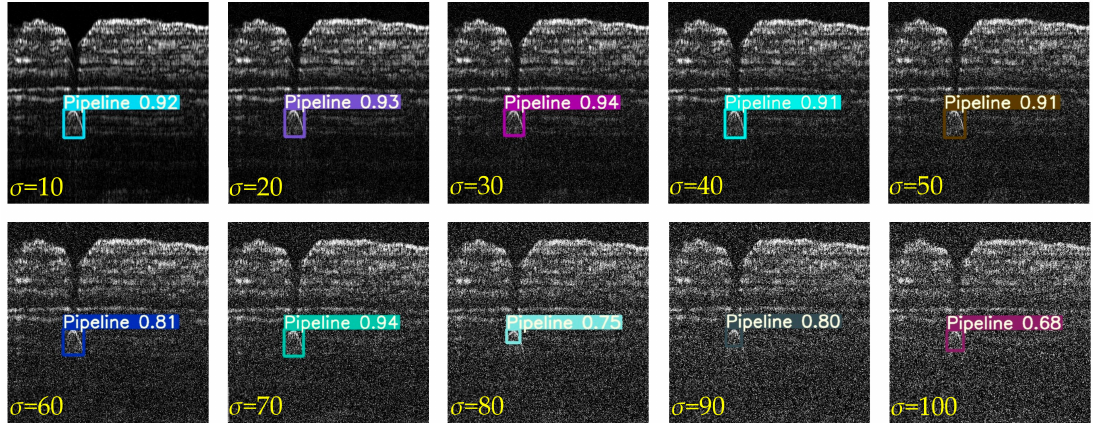
Figure 29. Detection results of the same sample at different noise